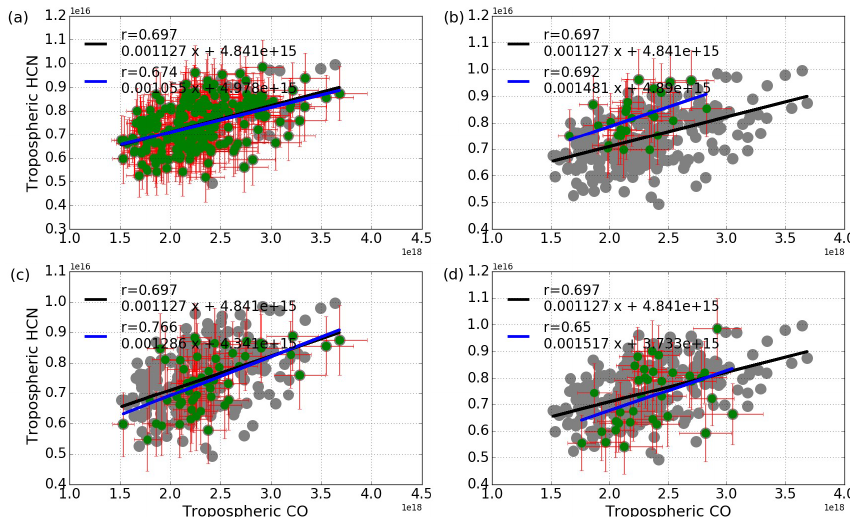
Figure 7. Correlation plots of daily mean tropospheric columns of HCN versus CO (moleculescm − 2 ) at Hefei (32 ◦ N). The gray dots represent all measurements and the green dots represent the measurements within the selected period: (a) measurements without March and April, (b) measurements in May, (c) measurements in September, and (d) measurements in December. The linear equation of the fit and the resulting correlation coefficient r are shown. The black line is a linear least-squares fit of the gray data and the blue line is for the green data. Error bars represent the retrieval uncertainties.